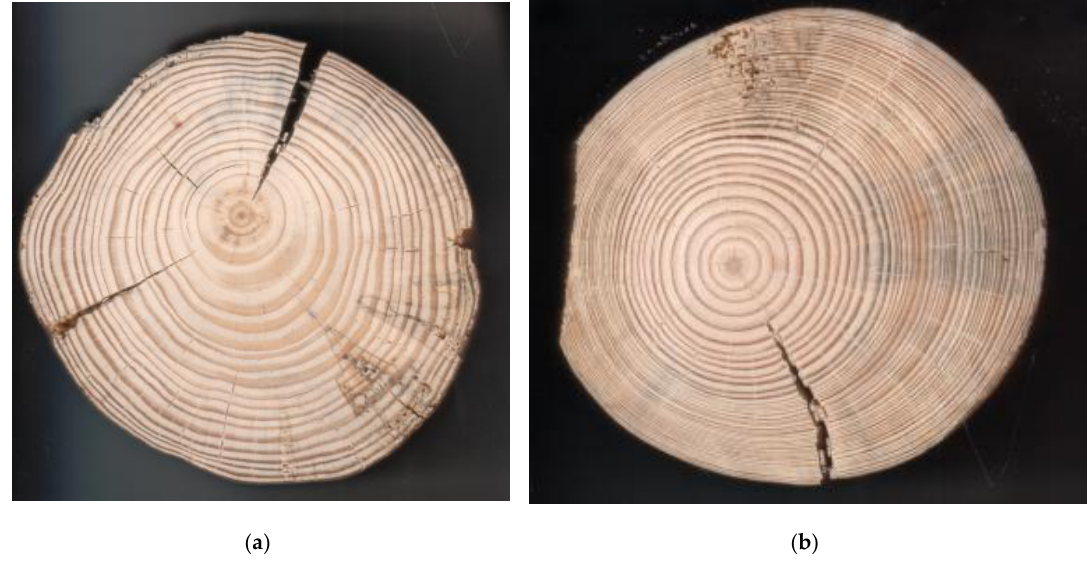
Figure 2. Cross-sections of typical pine wood samples taken from the forest road of the Koło Forest Inspectorate: (a) from section KRW1 of Rogóźno Forest District – sample So1-KRW1, (b) from section Inspectorate: ( a ) from section KRW1 of Rog ó ´zno Forest District—sample So1-KRW1, ( b ) from section KLG2 of Lipie Góry Forest District – sample no. So1-KLG2. KLG2 of Lipie G ó ry Forest District—sample no.